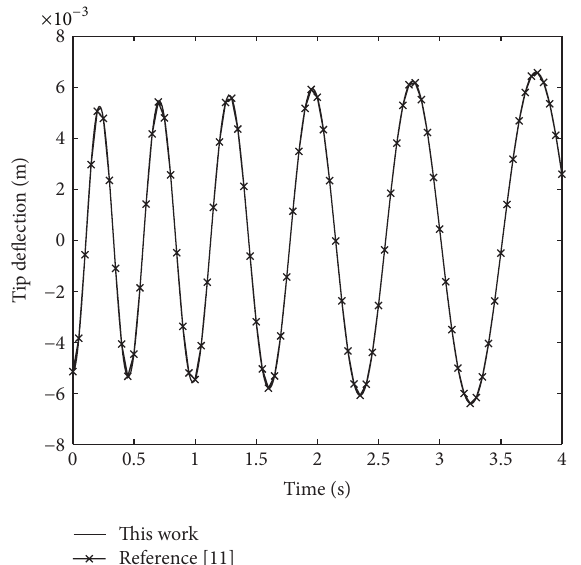
Figure 2: Tip deflection of the axially translating beam when 𝐿(𝑡) = 1.8 + 0.3𝑡 .